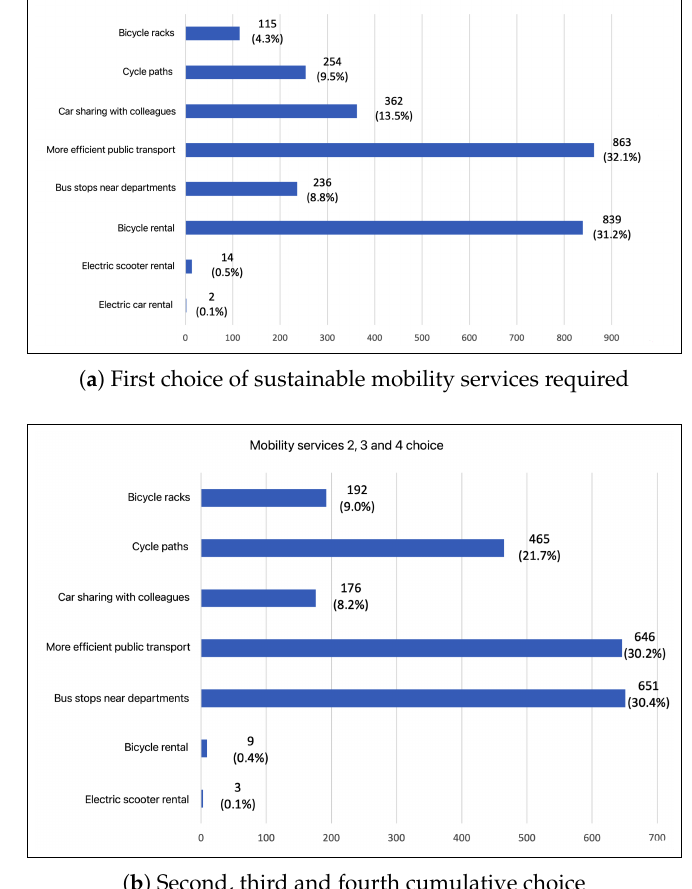
Figure 21. Sustainable mobility services